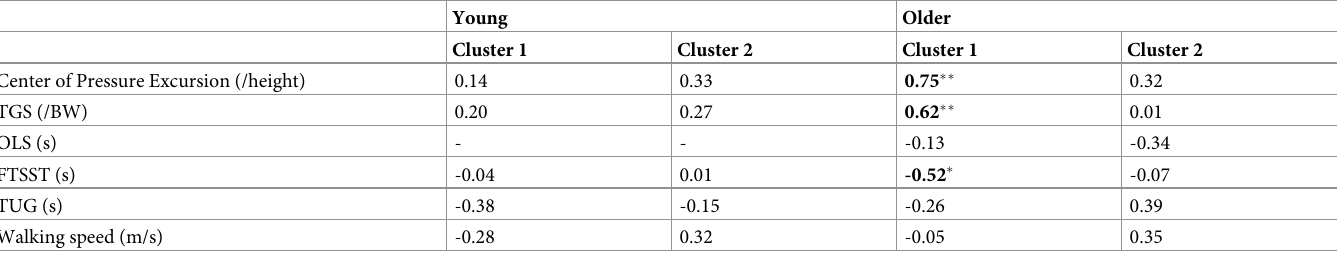
Table 3. Coefficients of correlation of parameters with the Functional Reach Test